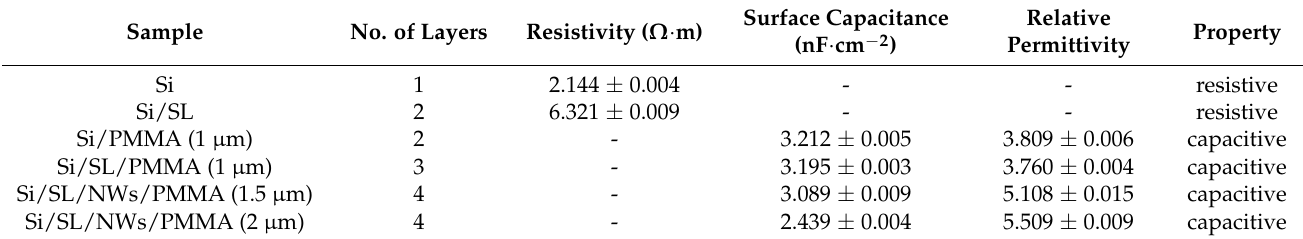
Table 1. Electrical measurement of different samples.